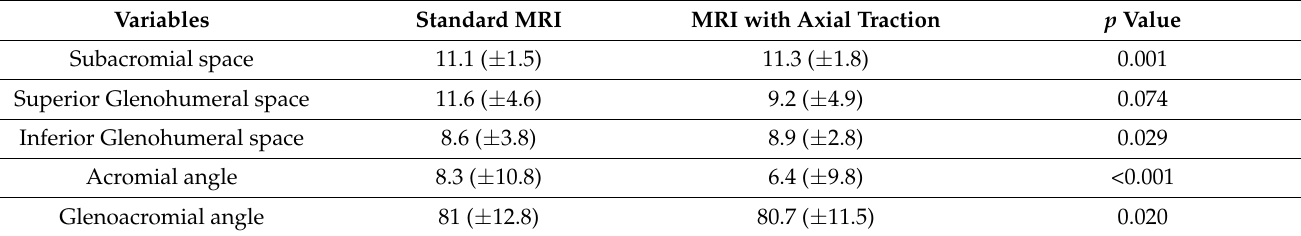
Table 4. Outcome